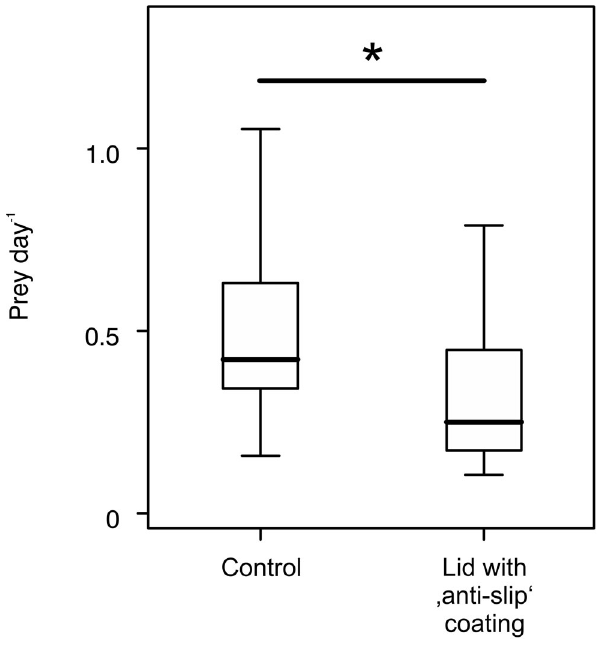
Figure 3. Biological relevance of the lid capture mechanism. The natural prey capture rate of pitchers with a non-slippery PDMS coating applied to the lower lid surface is reduced in comparison to the untreated control group (*: P , 0.05).